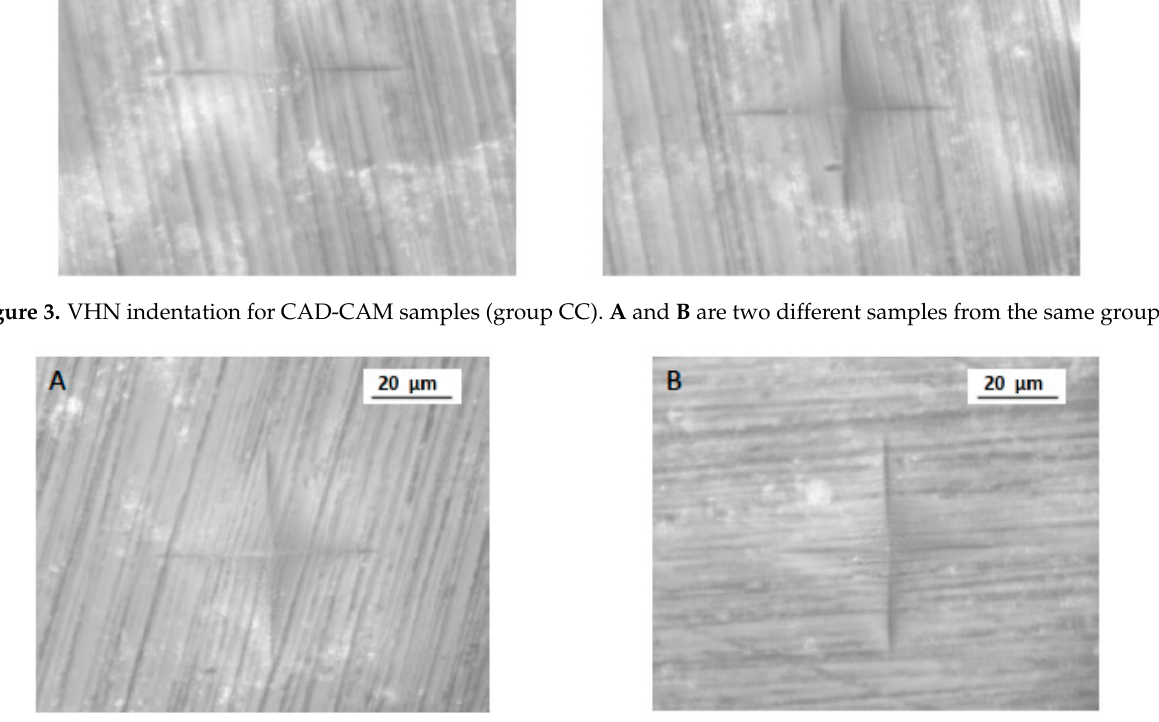
Figure 4. VHN indentation ( A , B ) for 3D-printed samples (Group 3D). A and B are two different samples from the same group.